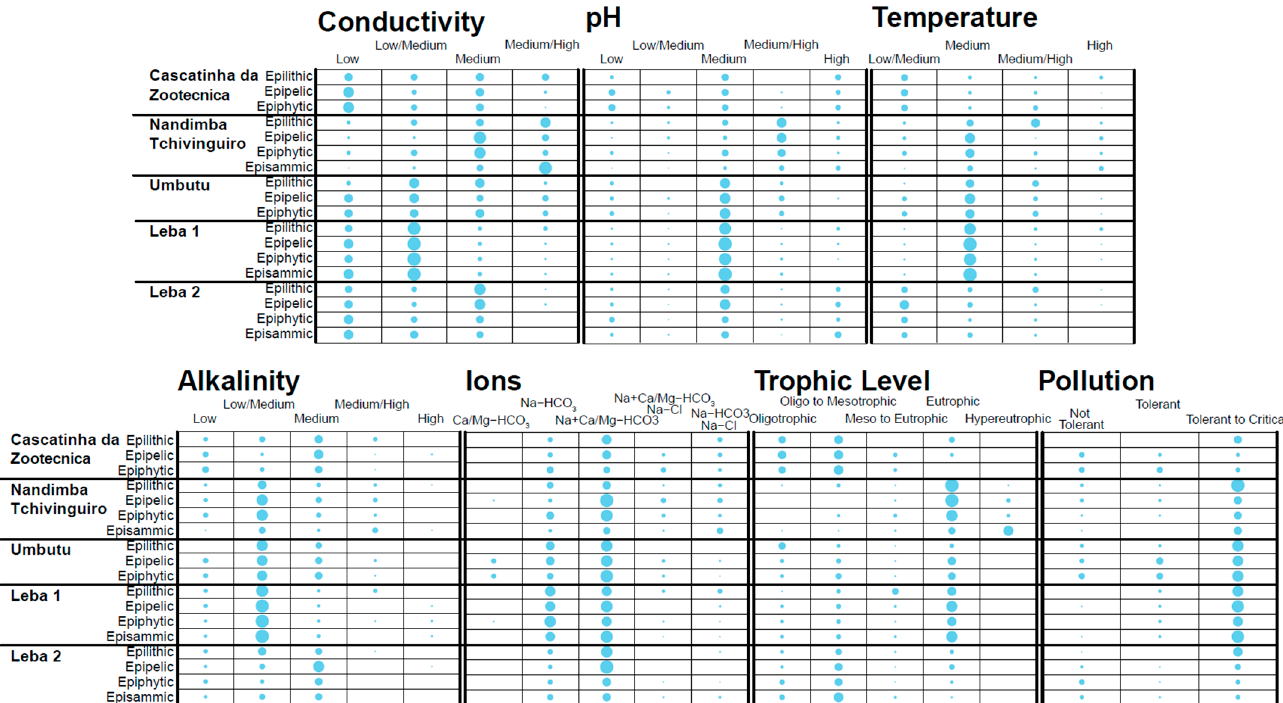
Figure 6. Balloon plots, which represent the percentage of the diatoms of each grouping based on the available data for each parameter, at each site divided by community. The organization for the groups is indicated in Table S3.